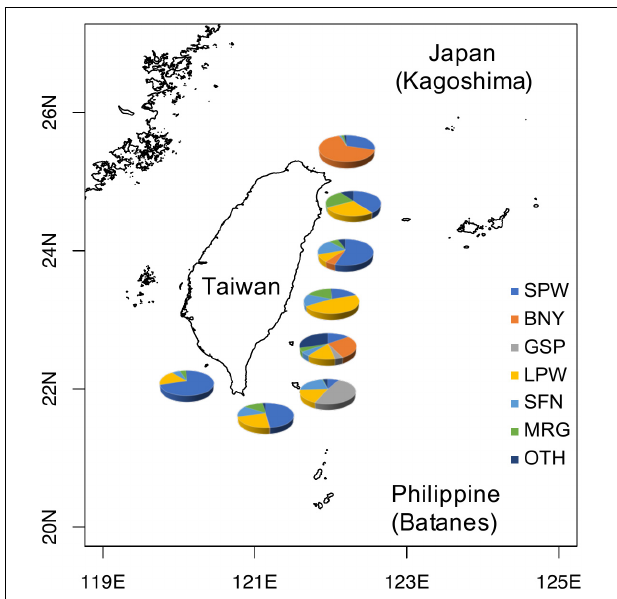
FIGURE 1 | Distribution of major flyingfishes occurring in the Kuroshio Current off eastern Taiwan. SPW, spotwing flyingfish ( Cypselurus poecilopterus ); BNY, bony flyingfish ( Hirundichthys oxycephalus ); GSP, greater spotted flyingfish ( Cheilopogon atrisignis ); LPW, limpidwing flyingfish ( Cheilopogon unicolor ); SFN, sailfin flyingfish ( Parexocoetus brachypterus ); MRG, margined flyingfish ( Cheilopogon cyanopterus ); OTH, other